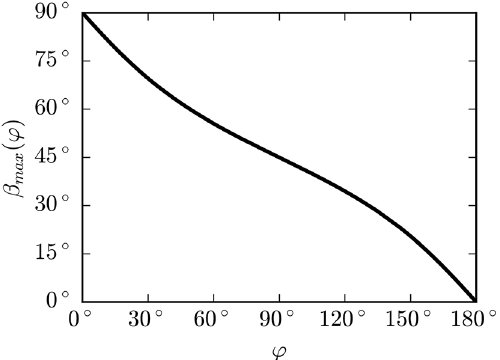
Figure 4. Calculated dependence of the polarizer angle β max for a given electric field directional vector ϕ for crystallographic